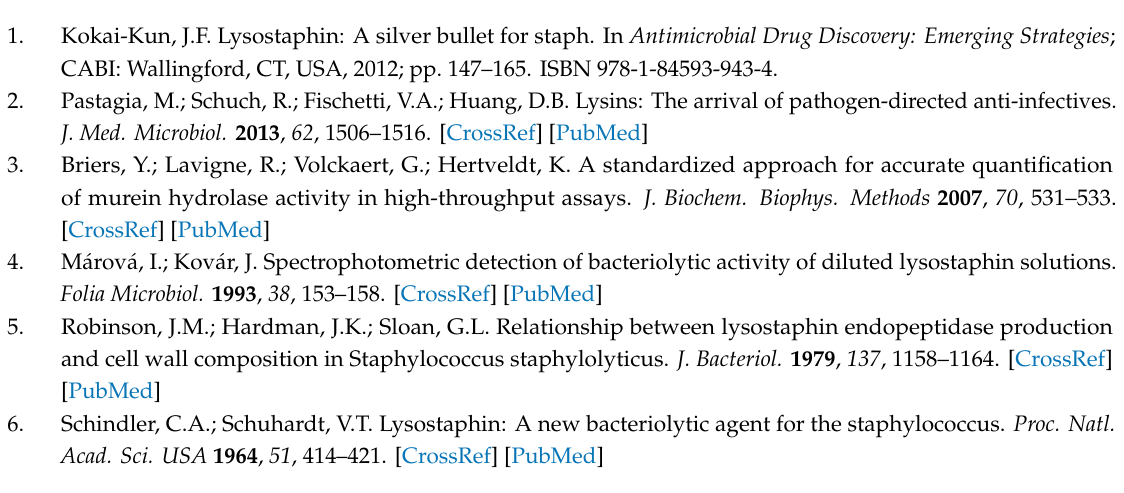
Figure S1: Separation of oligoglycine peptides of di ff erent length with thin-layer chromatography. Figure S2: Comparison of the catalytic activity of control and EDTA-treated lysostaphin variants. Figure S3: Pentaglycine does not spontaneously hydrolyze upon repeated freezing and heating. Excel: raw experimental data and calculations;